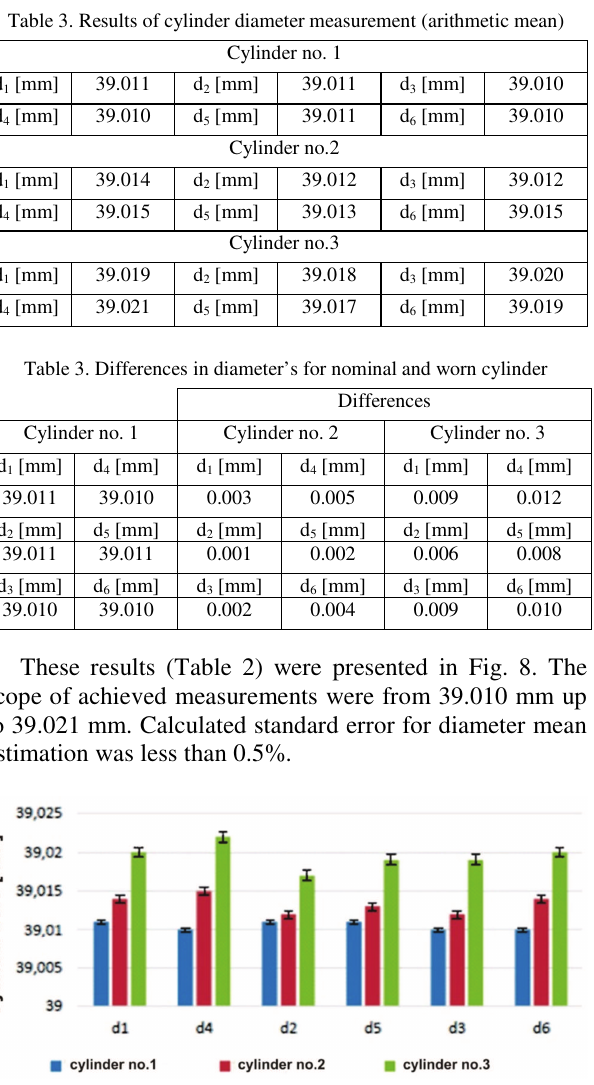
Fig. 8. Results of cylinder diameters measurements (arithmetic mean)